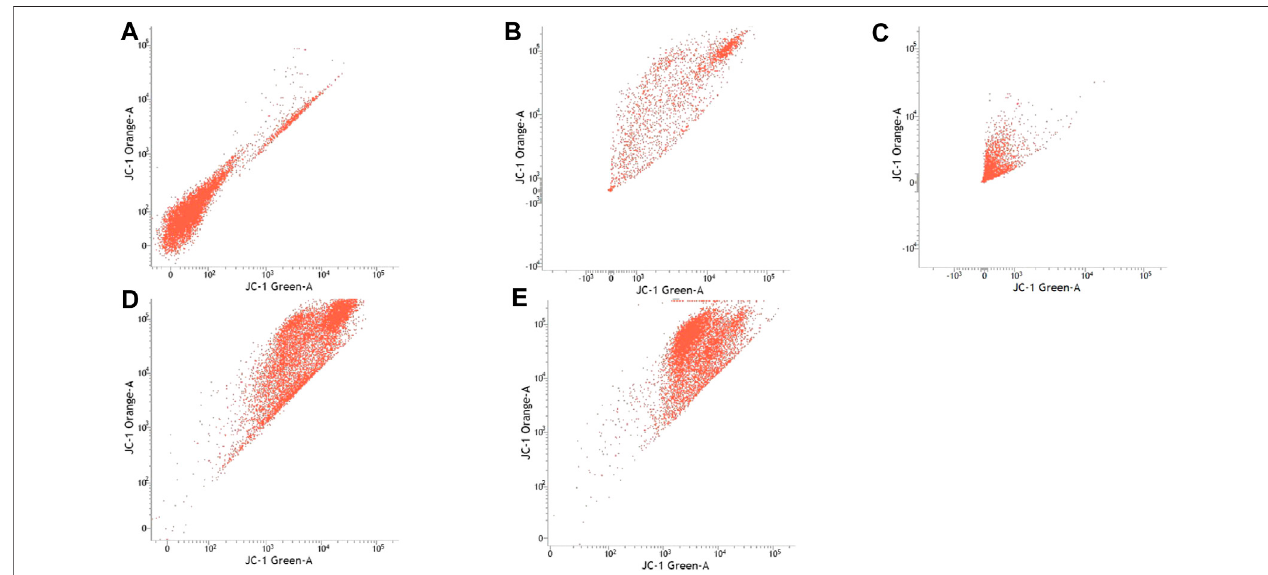
FIGURE5 | SH-SY5Y cell lines withor without treatmentwithsialic acidusing JC-1MitoProbe by BD FACSAria ™ : (A) untreated cell; (B) control withoutCCP; (C) control with CCP; (D) treatment with standard sialic acid; (E) treatment with extraction of sialic acid.